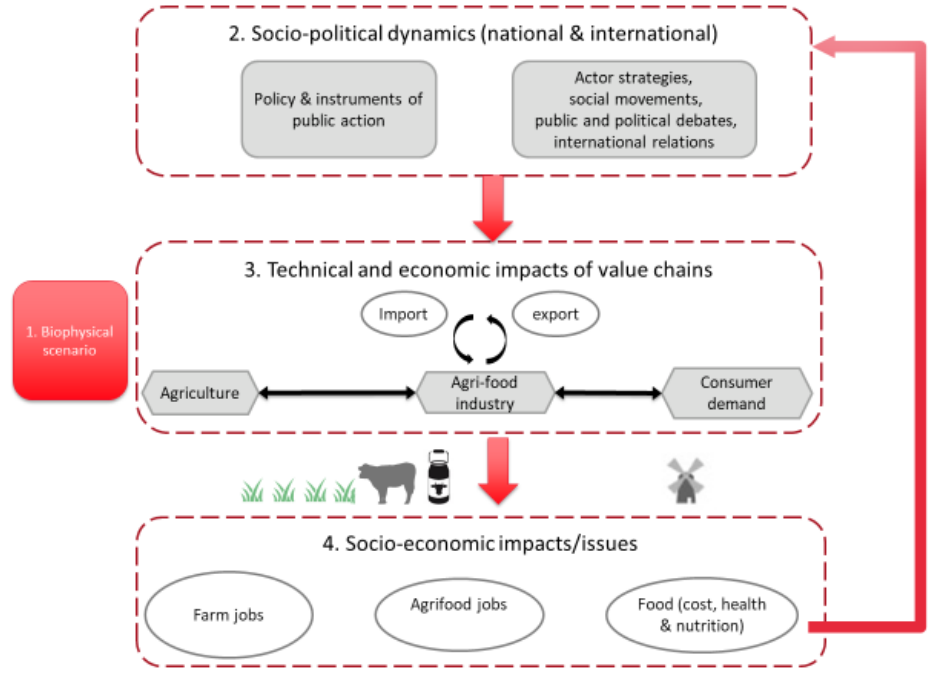
Figure 2. A simplified representation of MOFOT logical structure.